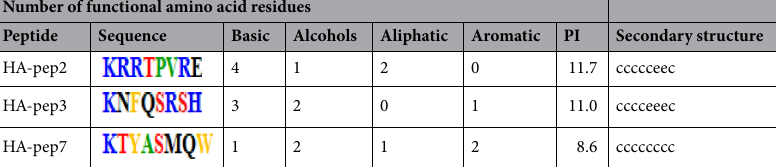
Table 1. Summary of representative binding peptides (HA-pep2, HA-pep3, and HA-pep7) to hydroxyapatite. Blue = basic, red = alcohols, green = aliphatic, orange = aromatic, black = all others, c = random coil, e = extended